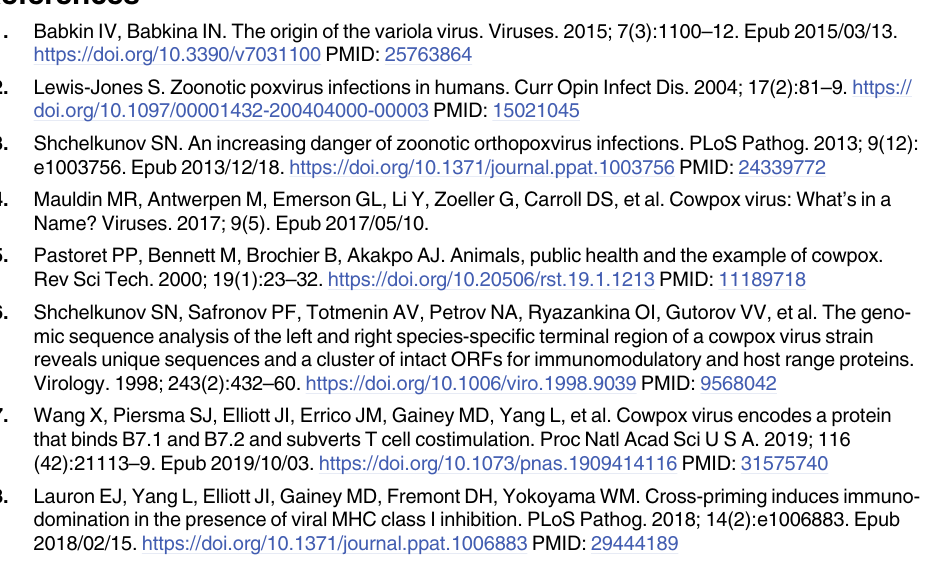
A for 6 hours at 37˚C. Following stimulation the cells were washed, then stained for surface markers, followed by fixation, permeabilization and ICS for TNF α and IFN γ as shown in S1 Fig. Error bars indicate SEM. B) CPXV14 does not inhibit stimulation OT-1 T cells by SIIN- FEKL peptide. Splenocytes from OT-I mice (C57BL/6J background) were pre-treated with 5 μ g/ml CPXV14-His (226 nM) for 4 hours and then stimulated with SIINFEKL peptide at the indicated concentrations in the presence of BFA for 6 hours. Splenocytes were surface stained and then subjected to ICS to quantitate production of OT-I specific TNF α . Plots in B show data from one representative mouse. C) Average frequency of TNF α -positive T cells of 3 mice (+SEM). The gating strategy was Lymphoctes (FSC/SSC)- > single cells - > live cells - >